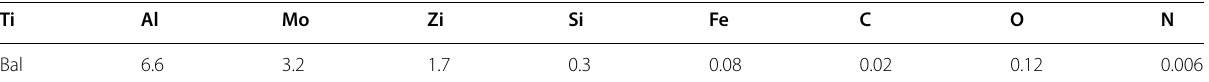
Table 1 Chemical composition of the alloy (wt.%)